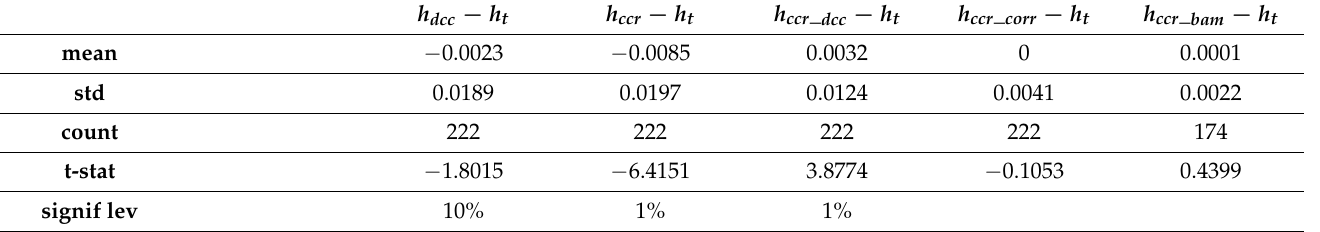
Panel D. HE Differences Aggregated across